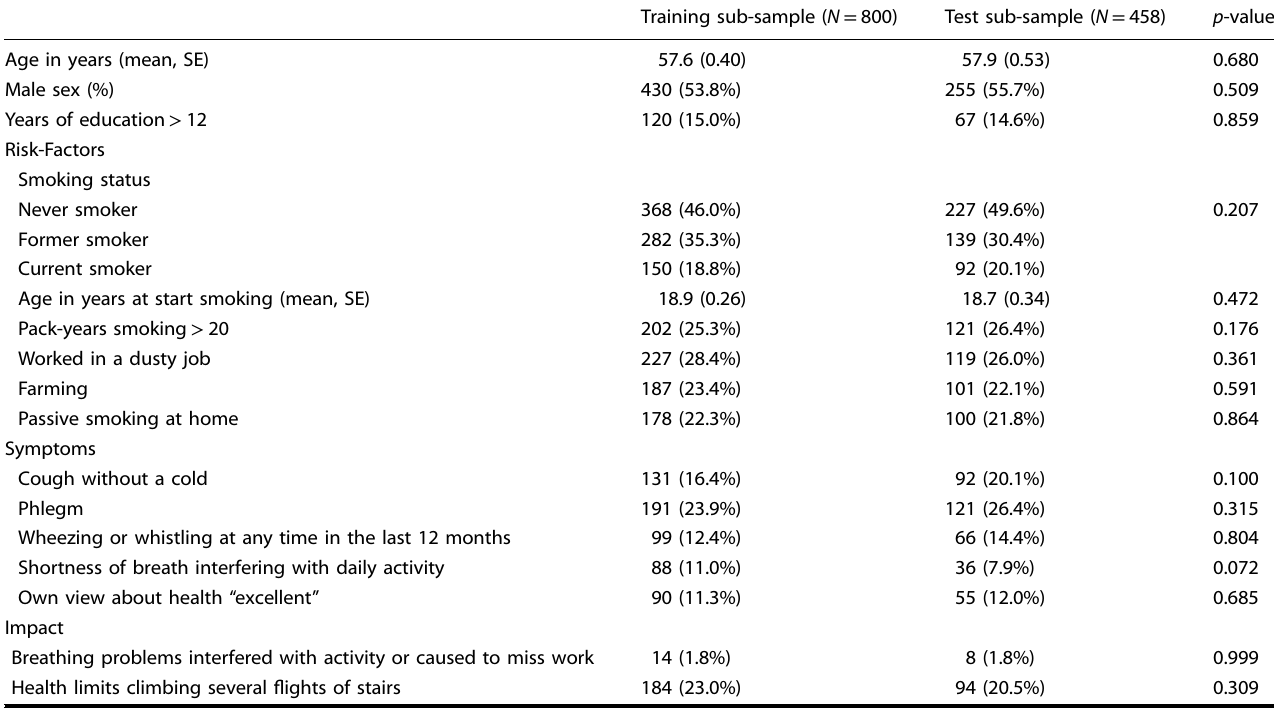
Table 1. Comparison of the training and test sub-sample